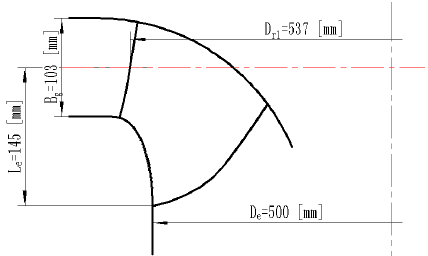
Figure 6. Meridional plane shape and basic dimensions.